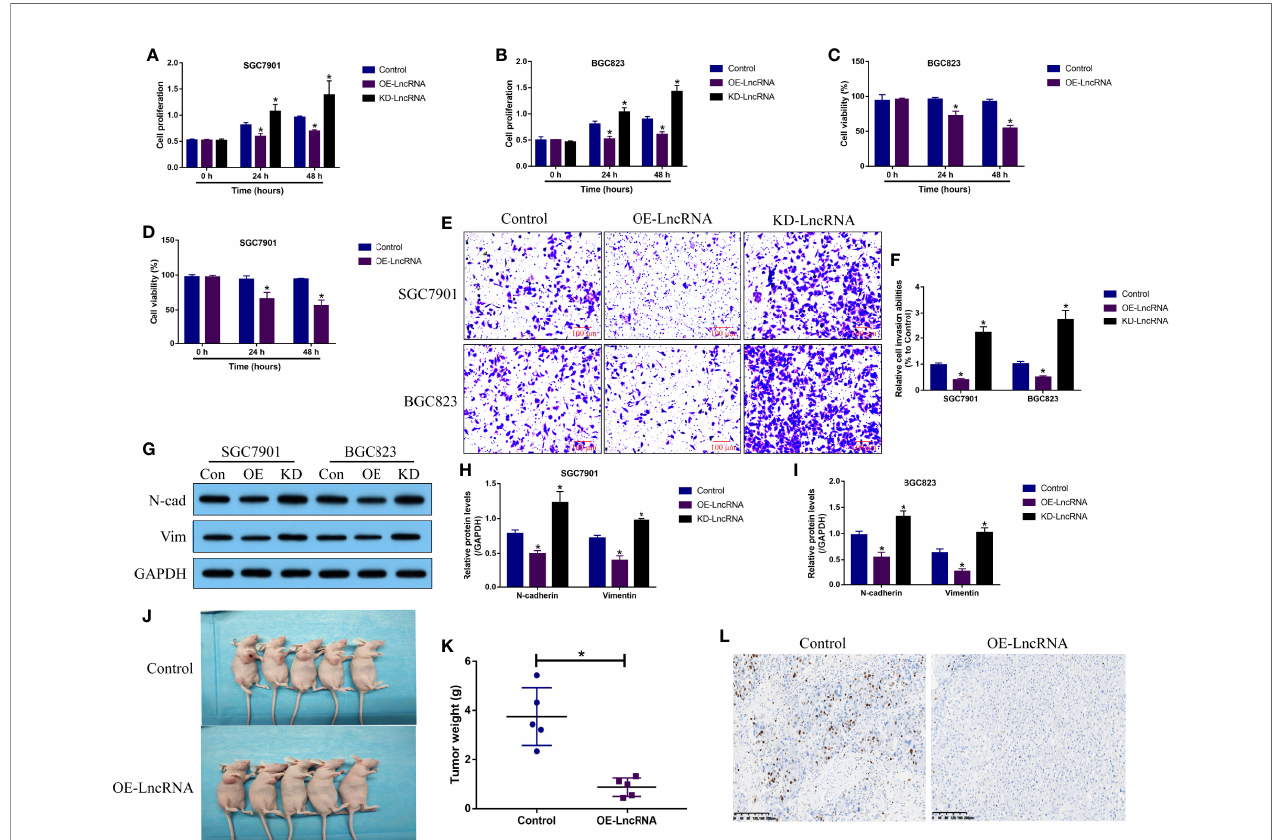
FIGURE 2 | LncRNA MIR503HG functioned as a tumor suppressor to reverse the malignant phenotypes in GC cells. (A, B) Cell proliferation abilities were analyzed by MTT assay, and further (C, D) trypan blue staining assay was performed to evaluate cell viability. (E, F) Cell invasion abilities were determined by using the transwell assay. (G – I) The Western Blot analysis was conducted to examine the expression levels of N-cadherin and Vimentin in GC cells, which were normalized by the GAPDH. “ OE ” represented “ LncRNA MIR503HG overexpression ” , and “ KD ” suggested “ LncRNA MIR503HG ablation ” . (J, K) The xenograft tumor bearing mice models were established by using the SGC7901 cells, and tumor weight were obtained. (L) Immunohistochemistry (IHC) assay supported that LncRNA MIR503HG downregulated Ki67 in mice tumor tissues. Each experiment contained 3 repetitions, and P < 0.05 were marked by “ * ”